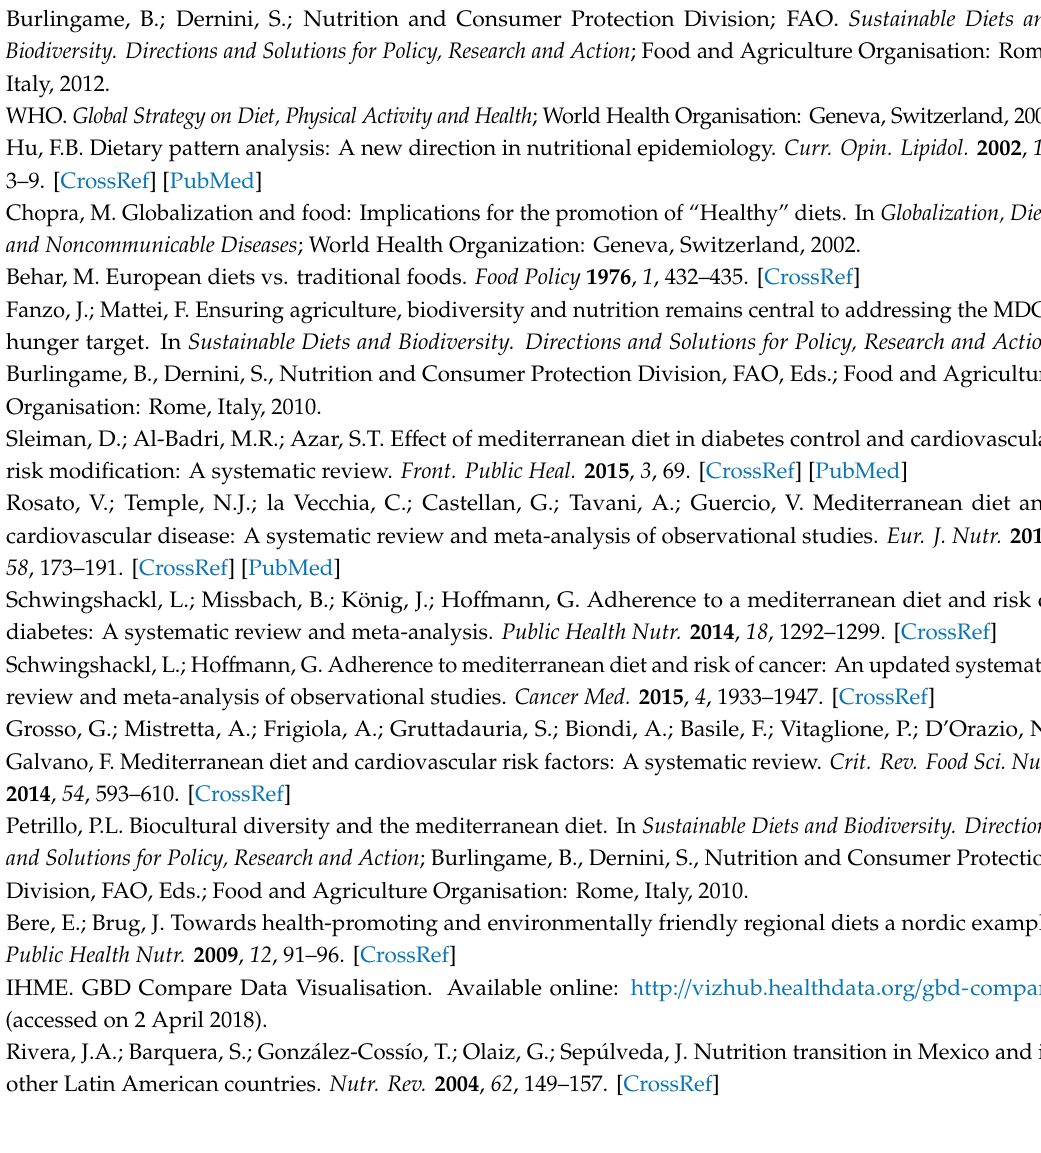
Table S5: Definition of the traditional Mexican diet according to di ff erent authors, Table S6 (a)(b)(c): Amounts of foods consumed in the traditional Mexican diet according to di ff erent authors, Table S7: Quality assessment of the included articles, Figure 1: Risk of bias assessment of the included articles, Table S8: Reporting quality assessment of the included articles, based on the STROBE 2007 checklist, Table S9: Reporting quality assessment of the included articles, based on the CONSORT 2010 checklist, Figure S2: Proportion of reported items in observational studies, based on the STROBE 2007 checklist, Table S10. Food groups mentioned in the di ff erent subgroups evaluated, Table S11. Individual foods mentioned in the di ff erent subgroups evaluated. Supplementary Material 2, Search